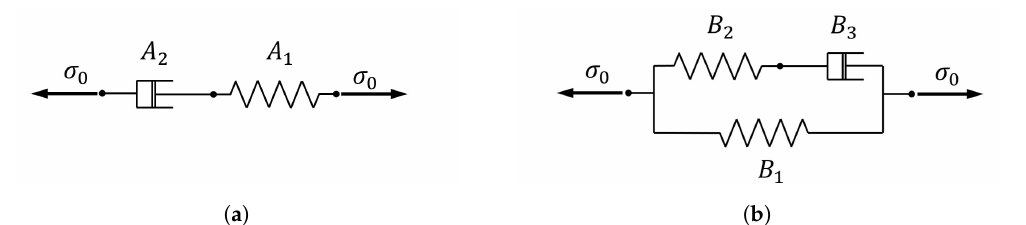
Figure 2. Scheme of the considered linear rheological models: ( a ) Maxwell model and ( b ) Linear Solid